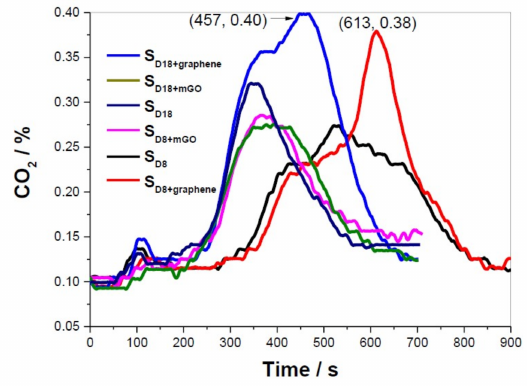
Figure 5. CO 2 concentration of exhaust pipe during combustion of